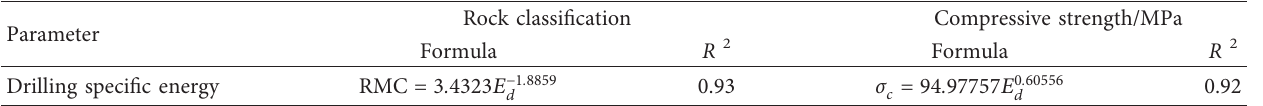
Table 16: Rock strength prediction model based on drilling specific